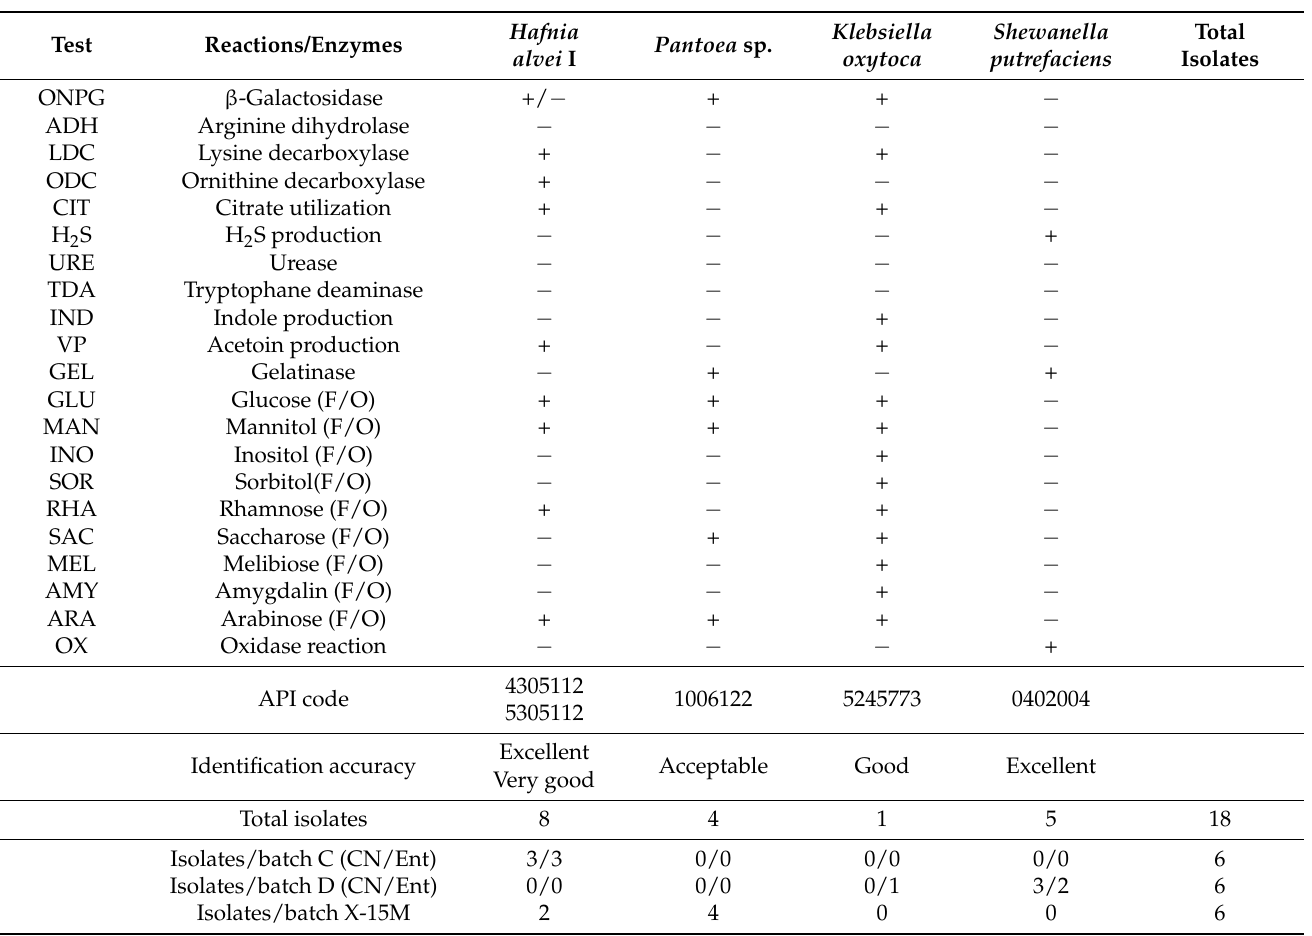
Table 5. Identification of additional 18 representative isolates of Gram-negative bacteria